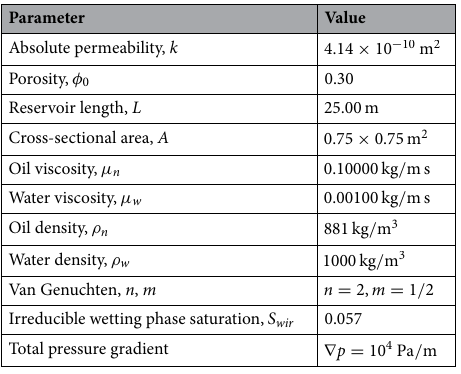
Table 1. Data used in the numerical simulations to be compared with the one-dimensional Buckley–Leverett waterflood problem.